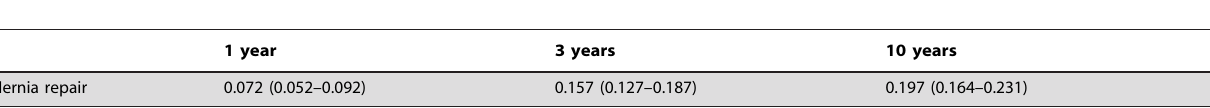
Table 2. Cumulative incidence of incisional hernias requiring surgical repair 1, 3, and 10 years after a cesarean